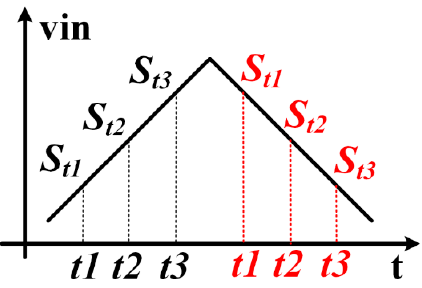
Figure 9. Triangular wave as the calibration input signal.